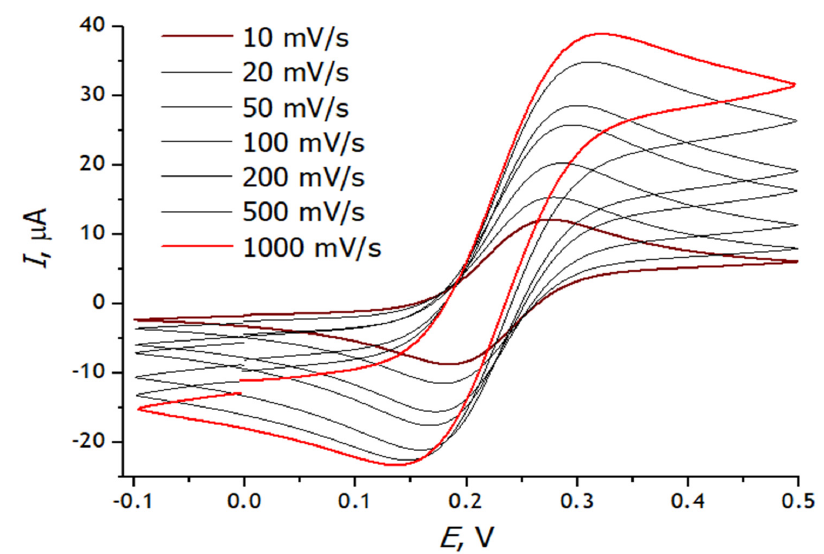
Figure 13. Experimental current–voltage curves of ferrocenemethanol.